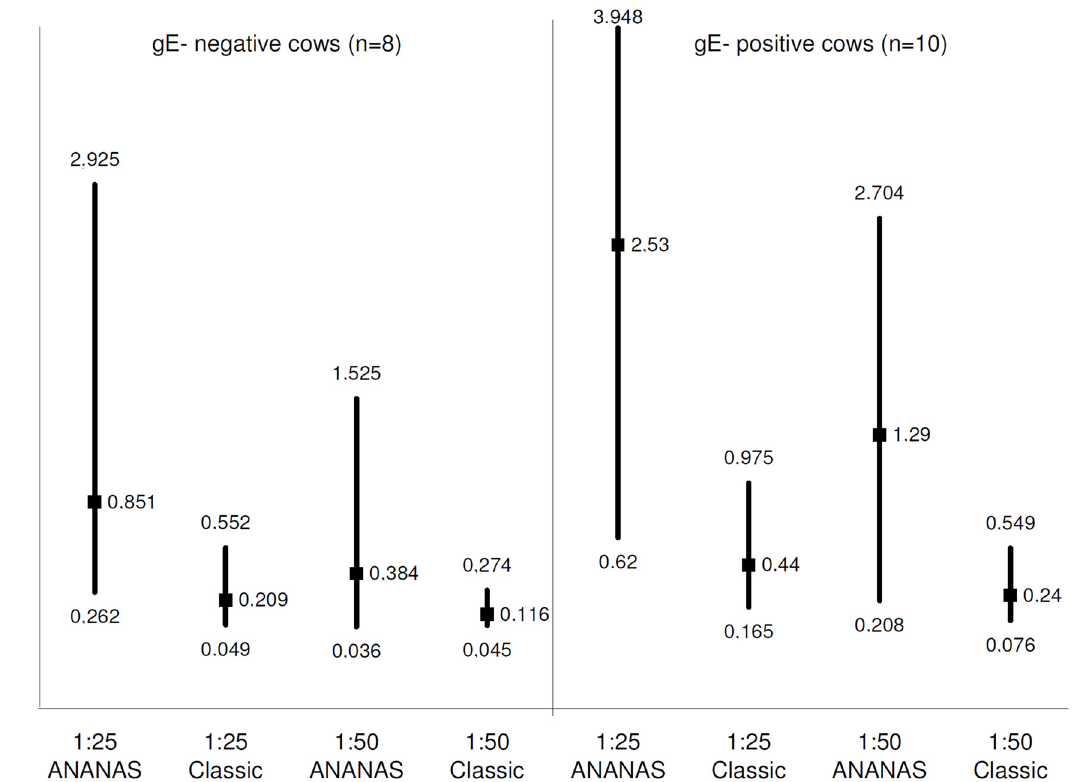
Fig 3. Assay sensitivity comparison in the pilot study. Maximum, minimum and median net OD values registered in the analysis of individual positive milk samples (no. 8 from gE-negative and no. 10 from gE-positive cows) diluted 1:25, 1:50 in negative diluting milk, using 1G10 in the classic or ANANAS- integrated configuration.